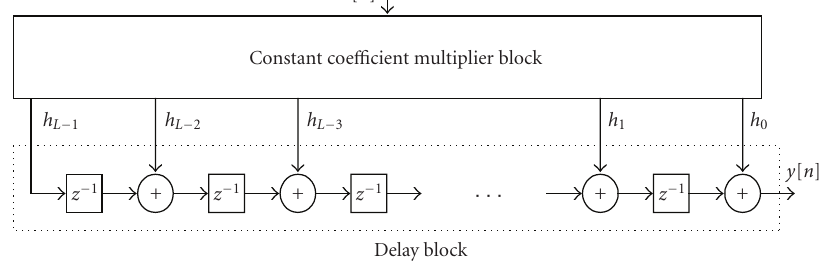
Figure 2: Constant multipliers of Figure 1(b) replaced by constant coe ffi cient multiplier